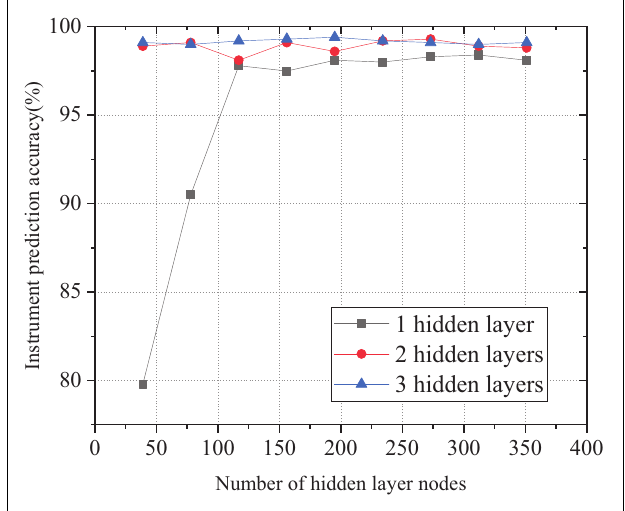
FIGURE 8 | Comparison of prediction accuracy of different hidden layers for national musical